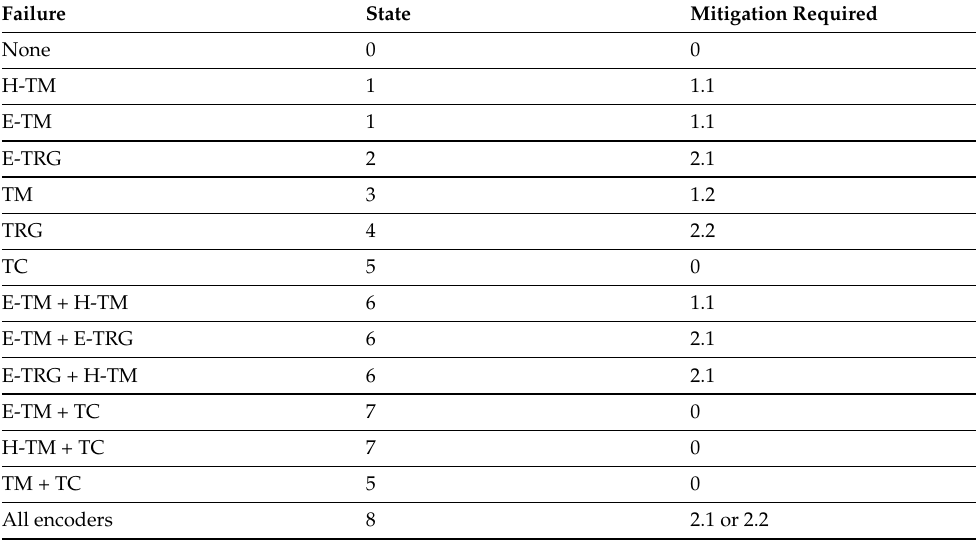
Table 5. Failure-state-mitigation associations for the traction